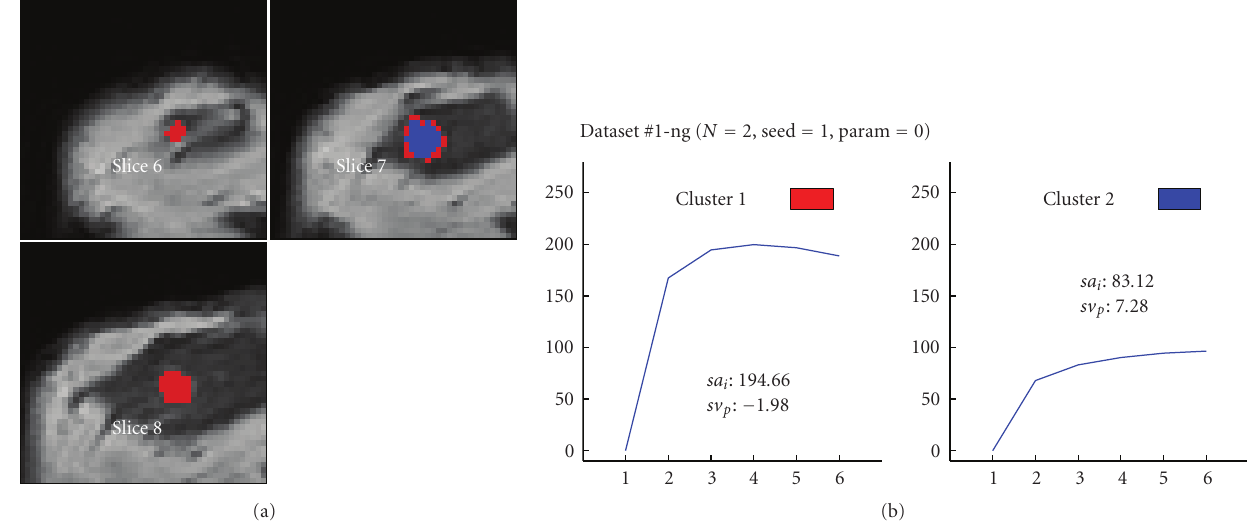
Figure 6: Segmentation based on the “neural-gas” network applied to data set #1 (malignant lesion, ductal carcinoma in situ (DCIS)) and resulting in two clusters. (a) shows the cluster distribution for each slice ranging from 6 to 8. (b) visualizes the representative time-signal intensity time curves for each cluster.